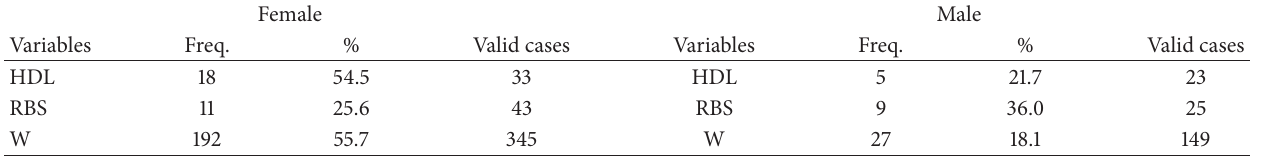
Table 3: Frequency of metabolic syndrome